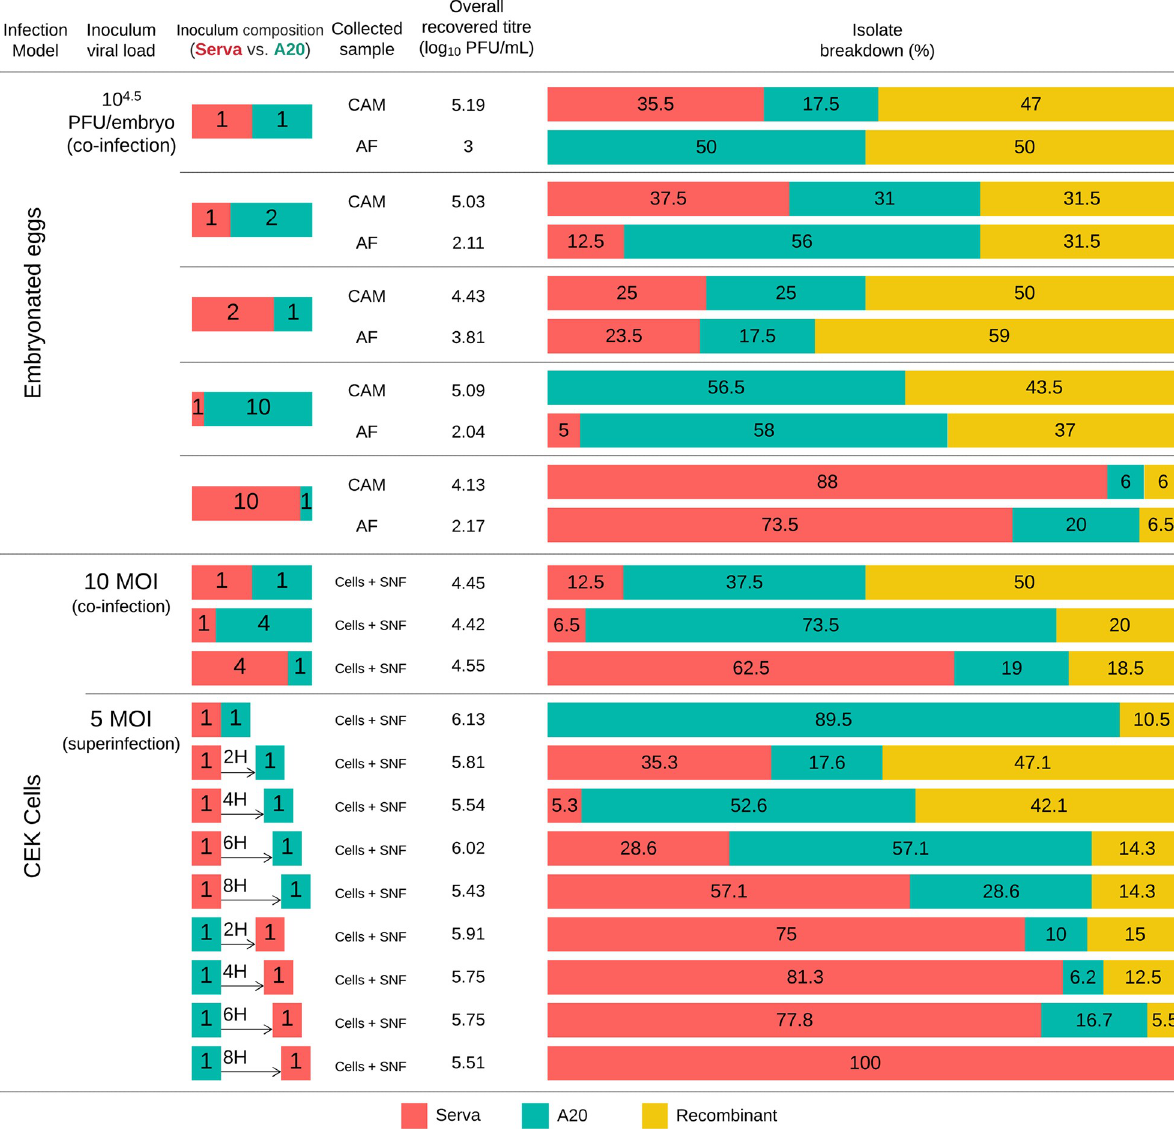
Fig 2. Summary of results from co-infection and superinfections in ovo and in CEK cultures. Proportions of parental strains or recombinants in both the inoculum and progeny viruses are shown as red (Serva), green (A20), or yellow (recombinant) blocks. The isolates from co-infection/ superinfection experiments on CEK cells were obtained from a combination of the cell lysate and the supernatant fluid (Cell + SNF) from the infected CEK monolayers. The isolates from the co-infection experiment in embryonated eggs were obtained from CAM homogenates or AF, which were collected separately. The overall titre of virus recovered from each infection condition is also